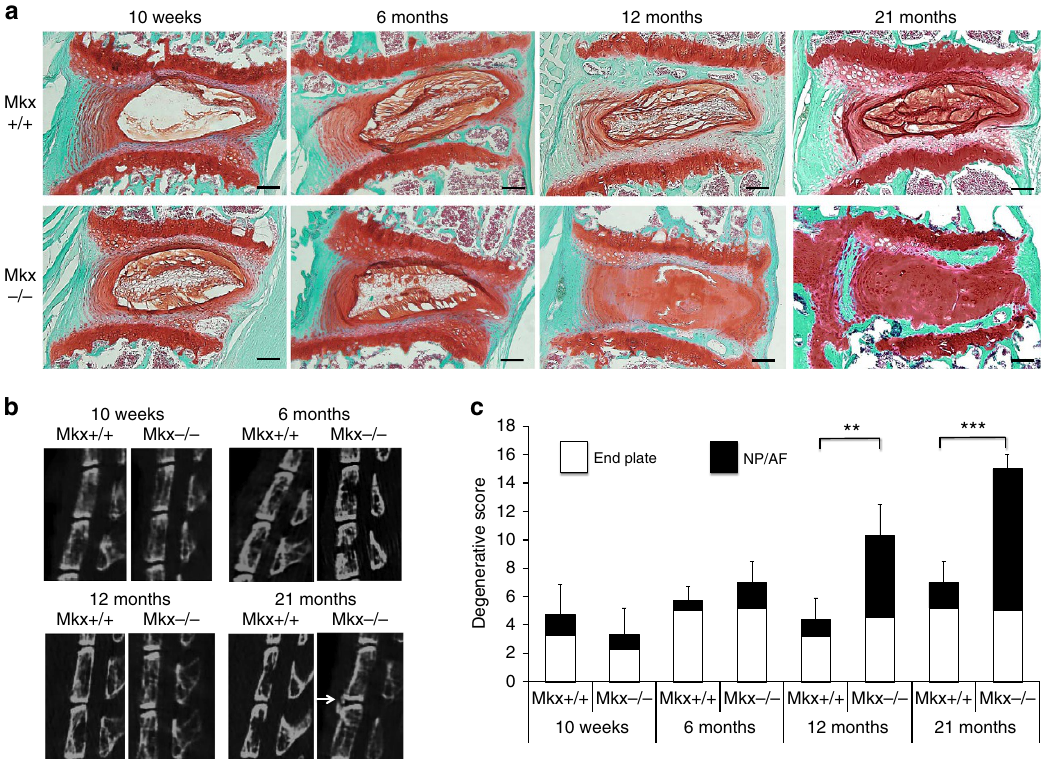
Figure 4 | Mkx (cid:2) / (cid:2) mice develop early onset disc degeneration. ( a , b ) Histological and computerized tomography (CT) changes with age between Mkx þ / þ and Mkx (cid:2) / (cid:2) mice. Safranin O fast green staining of sagittal sections of L3/4 ( a ) and sagittal CT images of the lumbar spine ( b ) at 10 weeks, and 6, 12 and 21 months. Scale bars, 300 m m. ( c ) Histological degenerative scores of intervertebral discs (IVDs) in Mkx þ / þ and Mkx (cid:2) / (cid:2) mice. Error bars represent s.e.m. ** P o 0.01, *** P o 0.001. Statistical differences were assessed with Student’s t